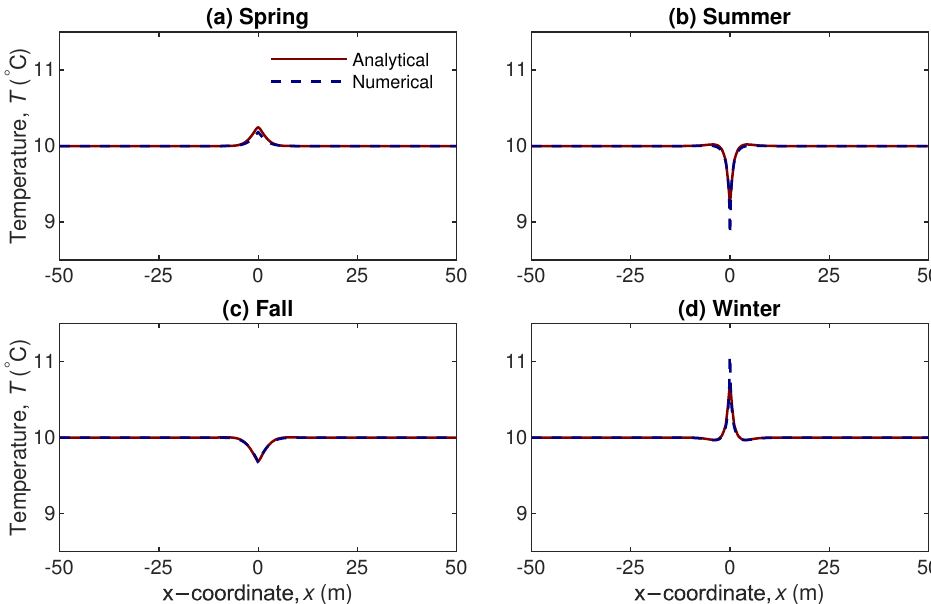
Figure 5. Temperature distribution over the x -coordinate (i.e., the line y = 0) for a single borehole over four seasons: ( a ) Spring ( t = 3 (mon)); ( b ) Summer ( t = 6 (mon)); ( c ) Fall ( t = 9 (mon)); and ( d ) Winter ( t = 12 (mon)). The analytical solution is given by the red solid line and the numerical solution is given by the blue dashed